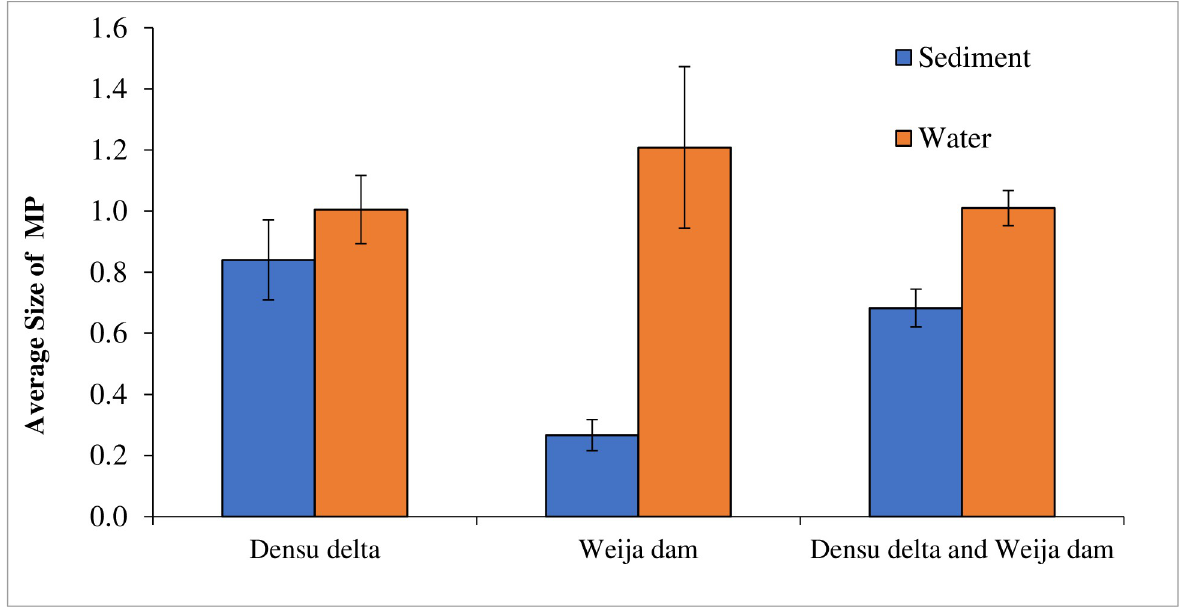
Fig 2. Size of microplastics in water and sediment of the Densu Delta and Weija Dam in Ghana.